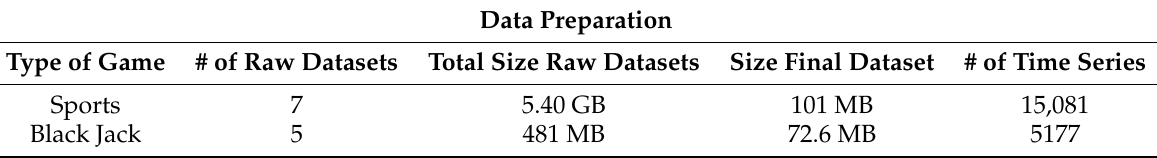
Table 1. Raw data set and processed data set. Data